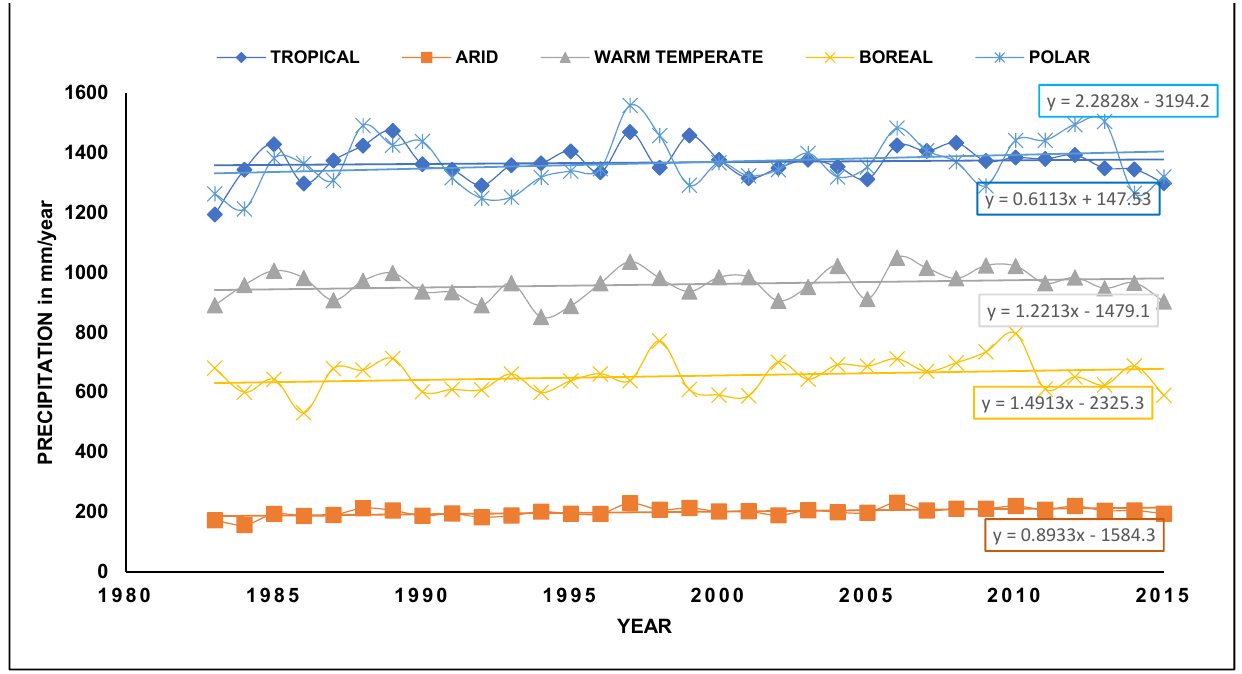
ISPRS Int. J. Geo-Inf. 2021 , 10 , x FOR PEER REVIEW